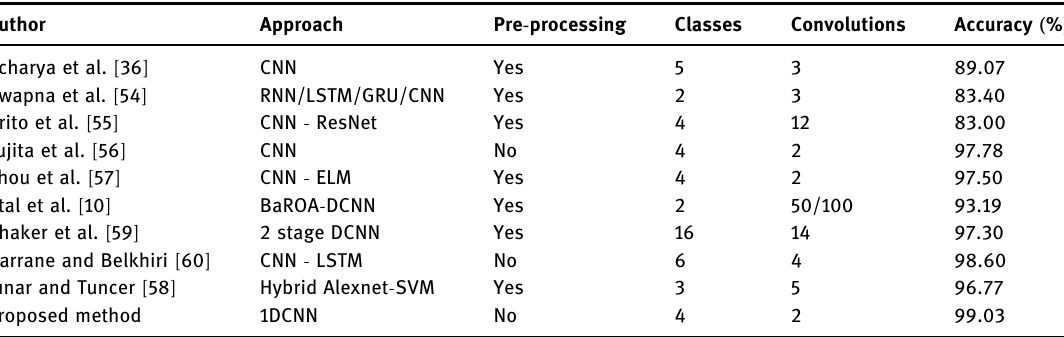
Table 4: Result comparison for beat classi fi cation using MIT - BIH